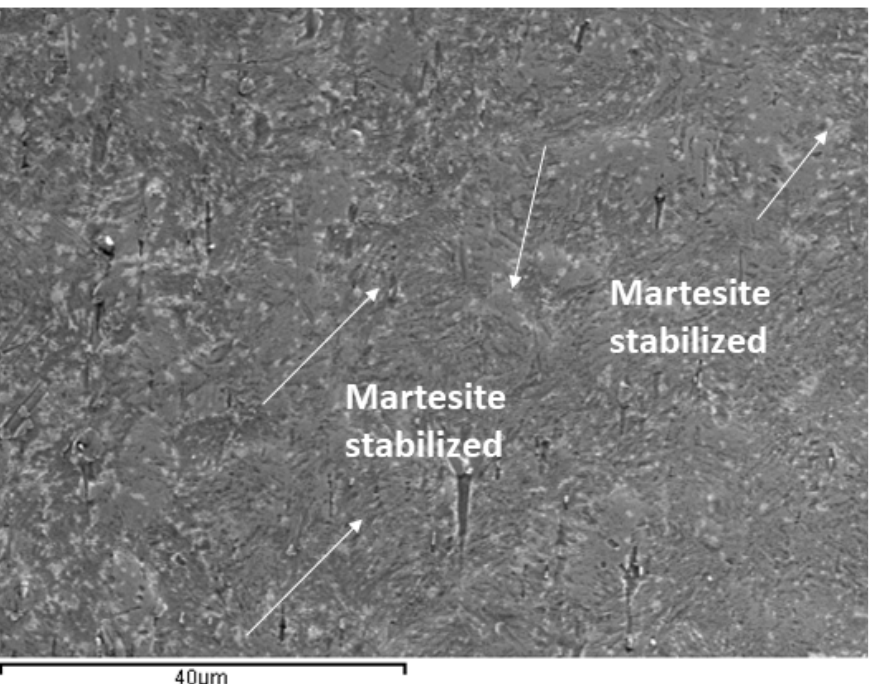
Figure 8. NiTi archwire surface after 7 days of immersion in mouthwashes with 380 ppb fluorides. Martensitic plates are observed.